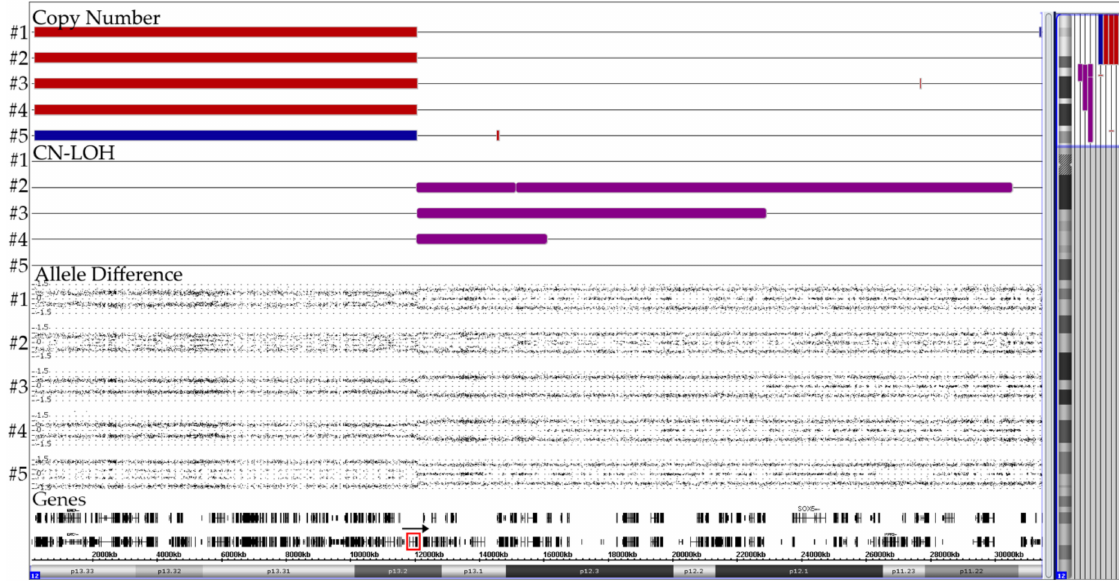
Figure 3. Summary of the CNA patterns on chromosome 12 in four cases with two non-identical der(12)t(12;21) (#1–4) copies and one with a der(21)t(12;21) (#5). The corresponding case numbers are shown on the left and the location of the ETV6 gene is marked with a red box in the gene track. The rearrangements in the ETV6 -surrounding region are far more complex than those in the RUNX1 -surrounding one and essentially reflect the difficulties that accompany the successful fusion of the reversely orientated RUNX1 and ETV6 genes. In the four cases with a der(12), the telomeric part (including ETV6 ) of the second chromosome 12 is deleted. The CN-LOH regions of the adjacent extended ETV6 -containing centromeric part of both homologues in three of them provide convincing evidence that these complex configurations must be produced simultaneously in a single step